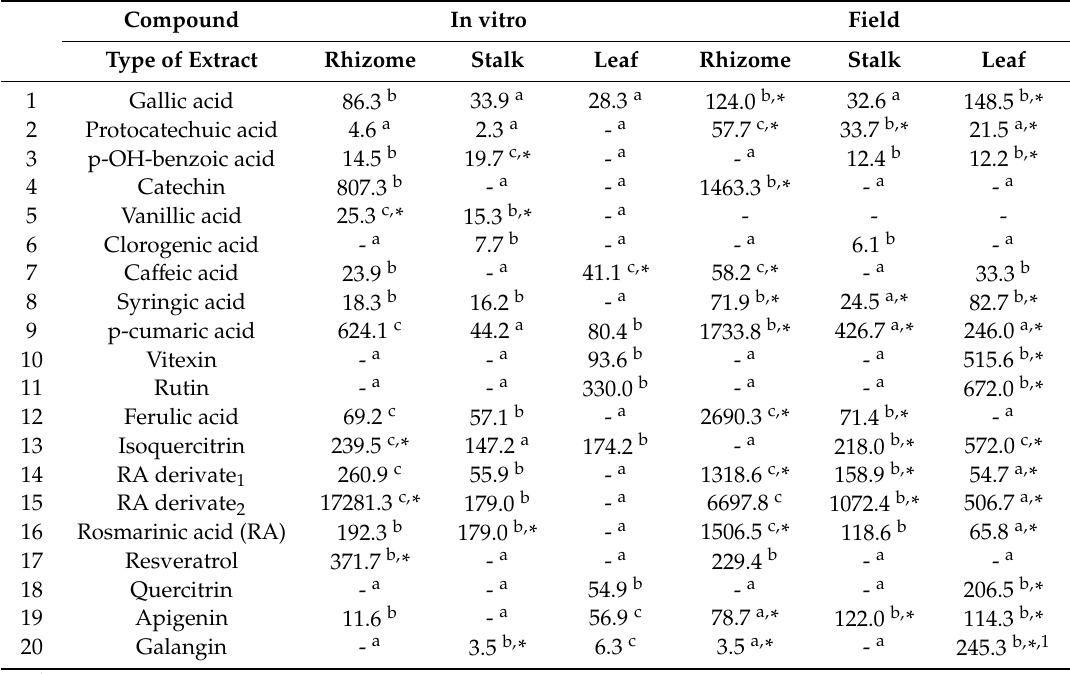
1 The values shown are means. Di ff erent lowercase letters indicate significant di ff erences between the means of chemical compounds in di ff erent type of extracts both from in vitro and field grown plants according to Tukey’s HSD test ( p ≤ 0.05). * indicate significant di ff erences between the means of in vitro and field grown plants of the same type of